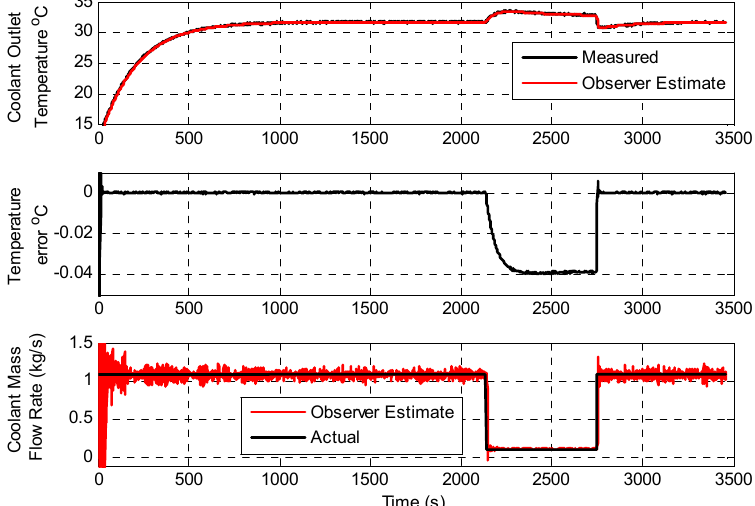
Figure 10. Comparative analysis of the Simulink-based and edge device-based (coolant flow fault case).